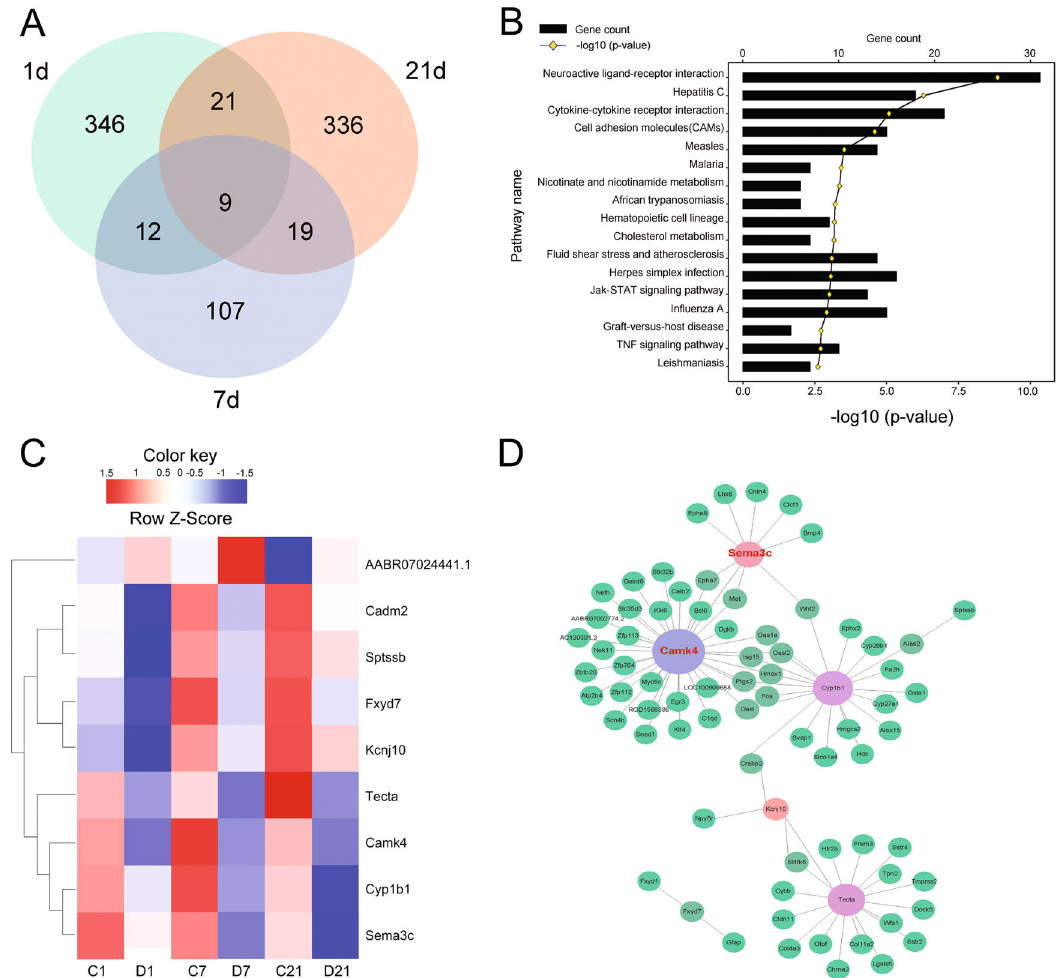
Fig. 4 Analysis of key player in mediating aberrant spine growth of DGC in the CH offspring of rat. A Integration of DEGs in the hippocampus of P1, P7, and P21 rat pups following CH. B Most signi fi cantly enriched groups for the integrated DEGs relating to pathways. C Heatmap and cluster dendrogram of integrated DEGs in the hippocampus of P1, P7, and P21 rat pups following CH. D A reconstructed gene network was created using the ingenuity pathway analysis software (IPA) on the basis of integrated